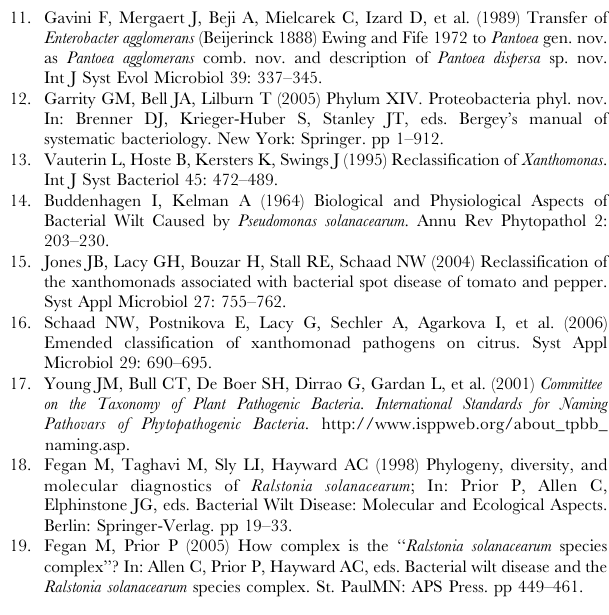
Table S6 Average between group distances of the RIF marker from ten different Dickeya RIF sequences. Table S7 Average between subspecies distances of the RIF sequence from eleven different Clavibacter michi- ganensis RIF sequences. Table S8 In silico comparison of Xanthomonas with the RIF marker resolves one pair of closely related strains that is unresolved with four other housekeeping genes and the ITS. Text S1 Computational derivation of a universal DNA marker from fifteen completely sequenced genomes was